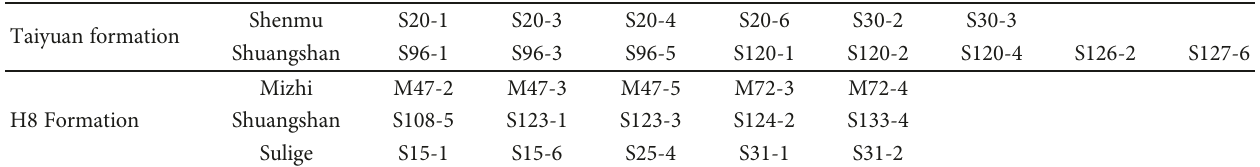
Table 1: Main experimental